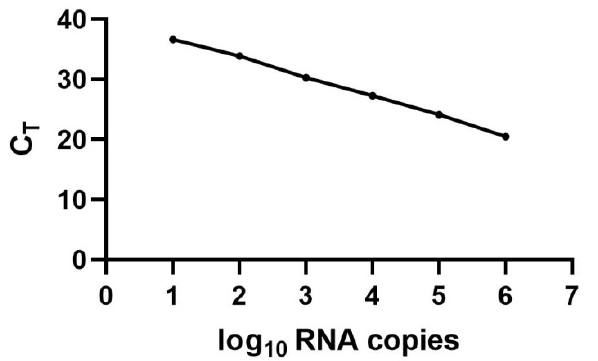
Figure 1. Standard curve of LJV. The y -axis shows the cycle threshold value (C T ), which represents the number of PCR cycles needed to reach the threshold of the fluorescent signal. The x -axis represents the log 10 of the absolute number of LJV RNA copies. The PCR efficiency is 98%, and the limit of quantification is 4 copies of the template corresponding to a C T value of 37.